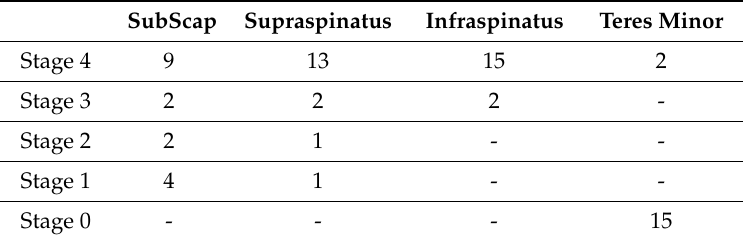
Table 2. Distribution of fatty infiltration of rotator cuff muscles. SubScap Supraspinatus